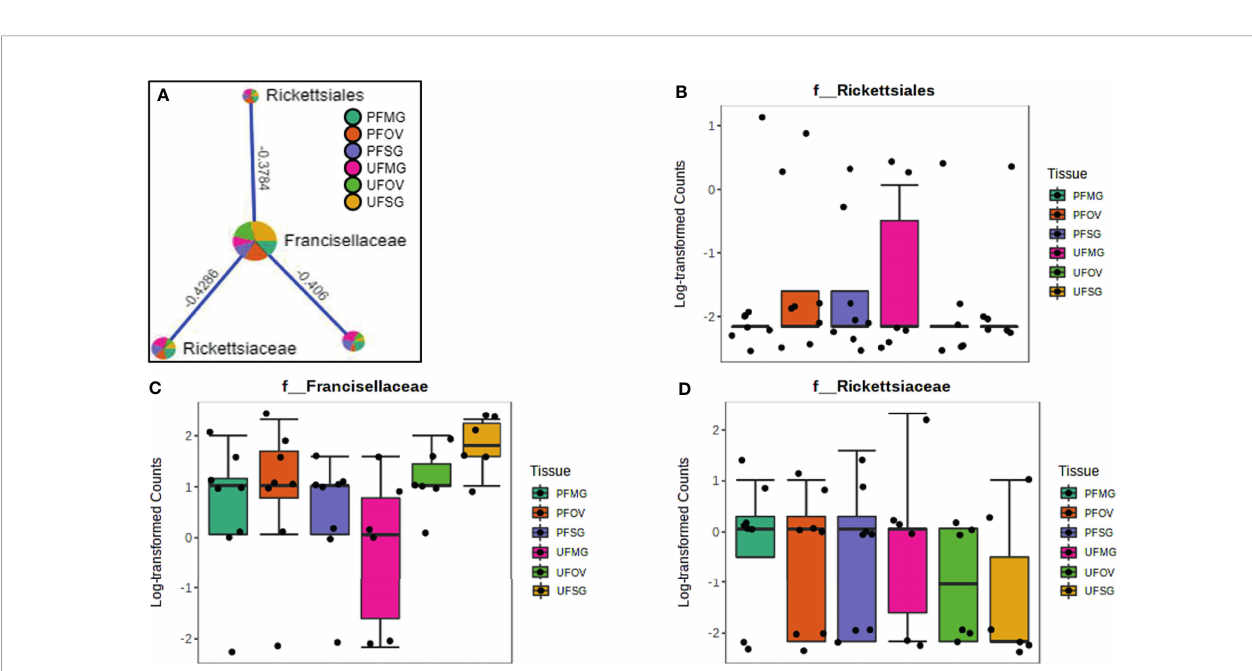
FIGURE 9 | Correlation network analysis in different tissues of ticks from Delaware. Correlation network generated using the SparCC algorithm. Correlation network with nodes representing taxa at the family level and edges representing correlations between taxa pairs (A) and representative boxplots showing enriched abundance of Rickettsiales (B) , Francisellaceae (C) , and Rickettsiaceae (D) across all